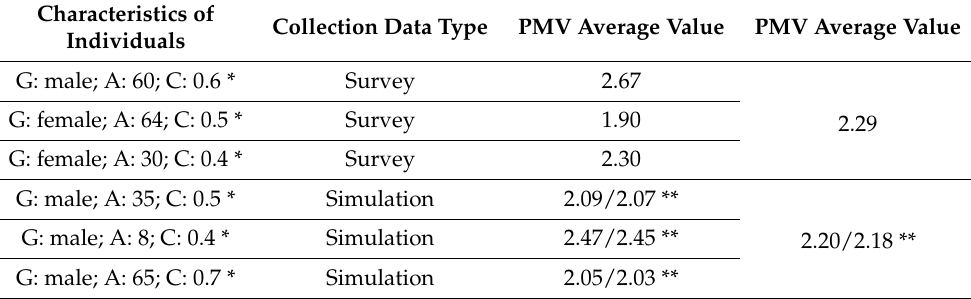
simulations for interviewees and simulated